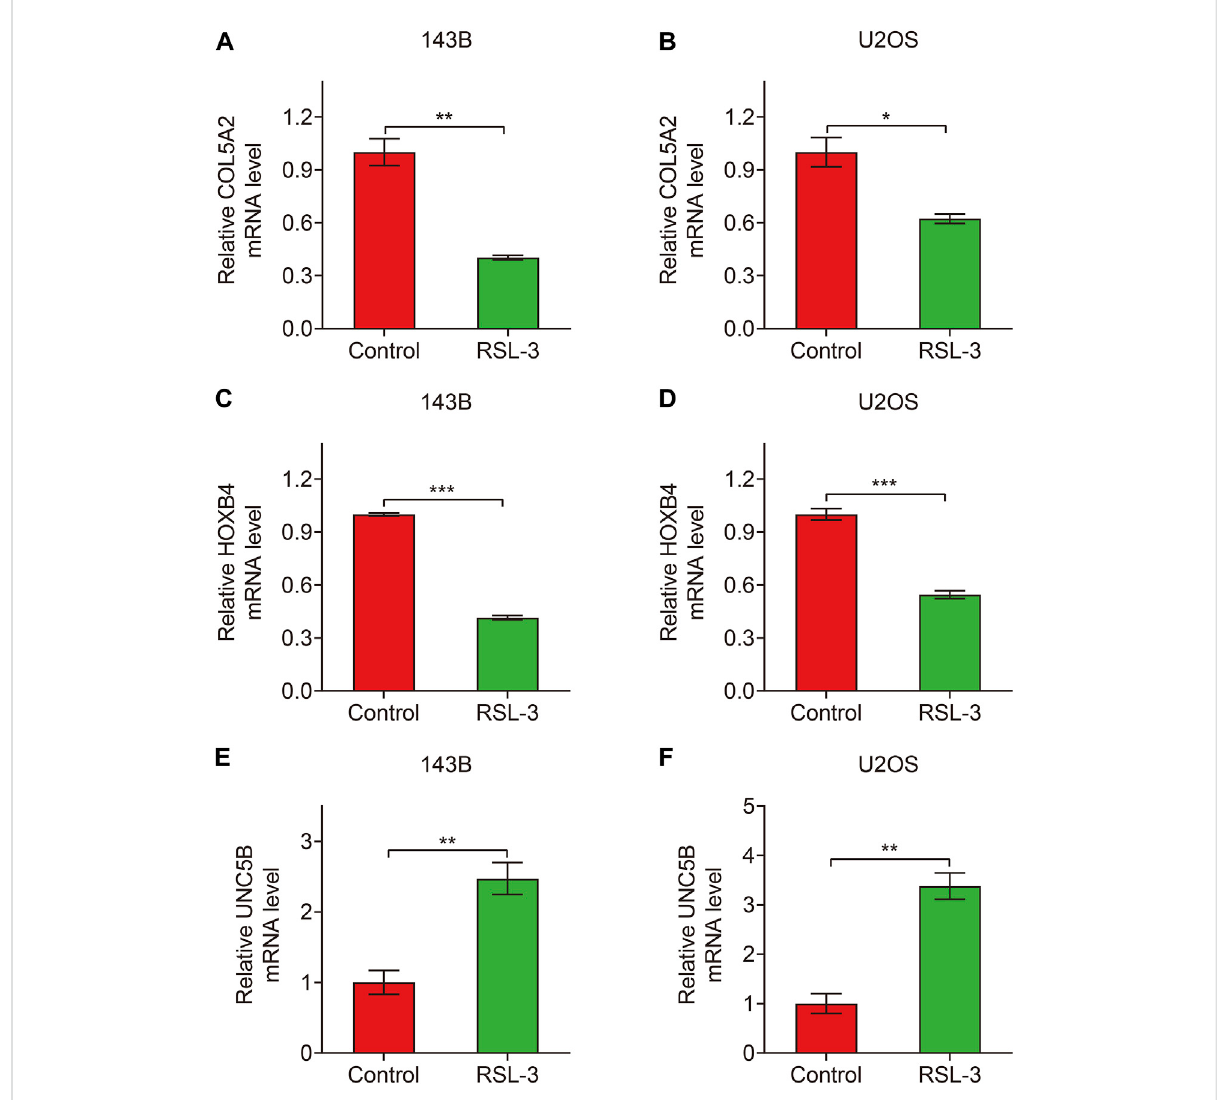
FIGURE 12 Relative expression of COL5A2 (A,B) , HOXB4 (C,D) , and UNC5B (E,F) in control and RSL3-treated osteosarcoma